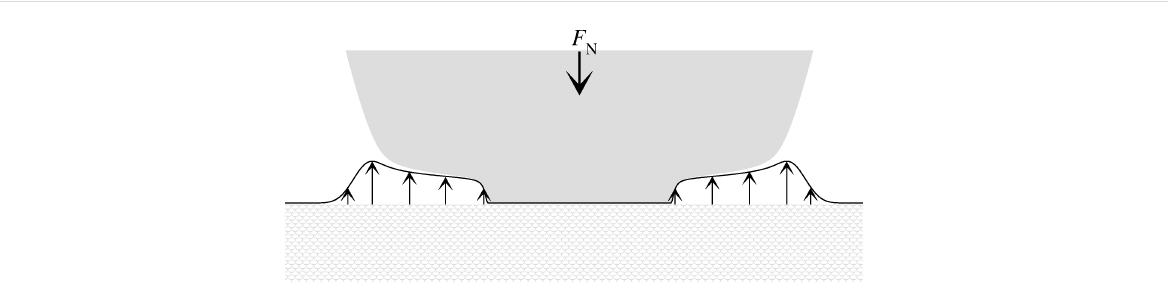
Figure 20: Contact geometry for a Gauss model with finite-range repulsion. Arrows indicate the direction of normal load F N (thick arrow) and that of the finite-range repulsion (thin arrows) acting in addition to a hard-wall constraint. No adhesive forces between the surfaces are considered.